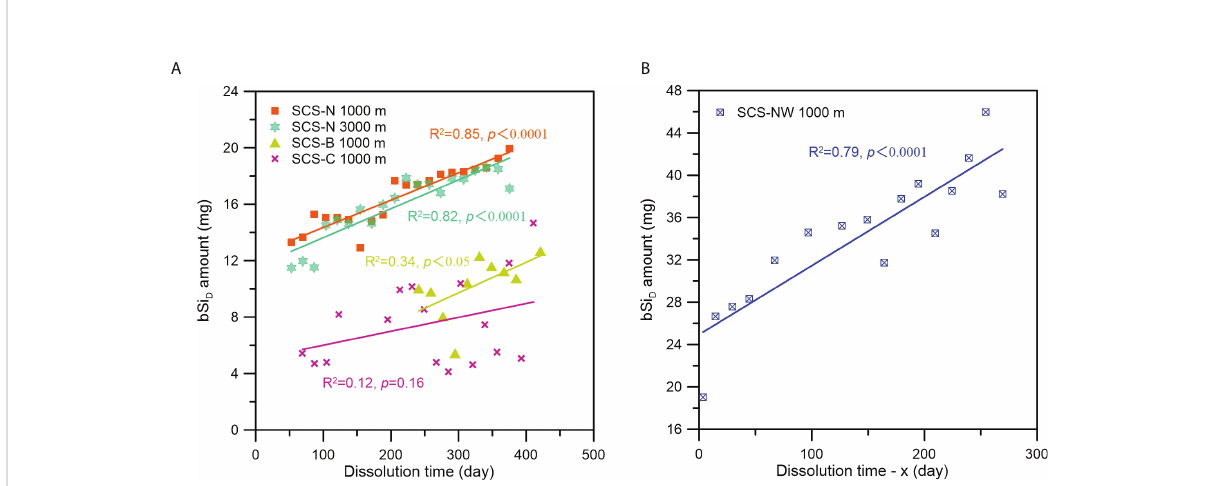
FIGURE 6 Relationship between the bSi D amount and the dissolution time at the different stations (A . station SCS-N, SCS-B and SCS-C; (B) station SCS- NW ) in the SCS. Note: Because the time when the supernatant taken in the laboratory for station SCS-NW samples was not recorded exactly, we de fi ned a constant x as the time period from the recovery time of the sediment trap to the time when the supernatant was taken in the laboratory, and the “ Dissolution time - x ” is the time period from the sampling time of each bottle to the recovery time of the sediment